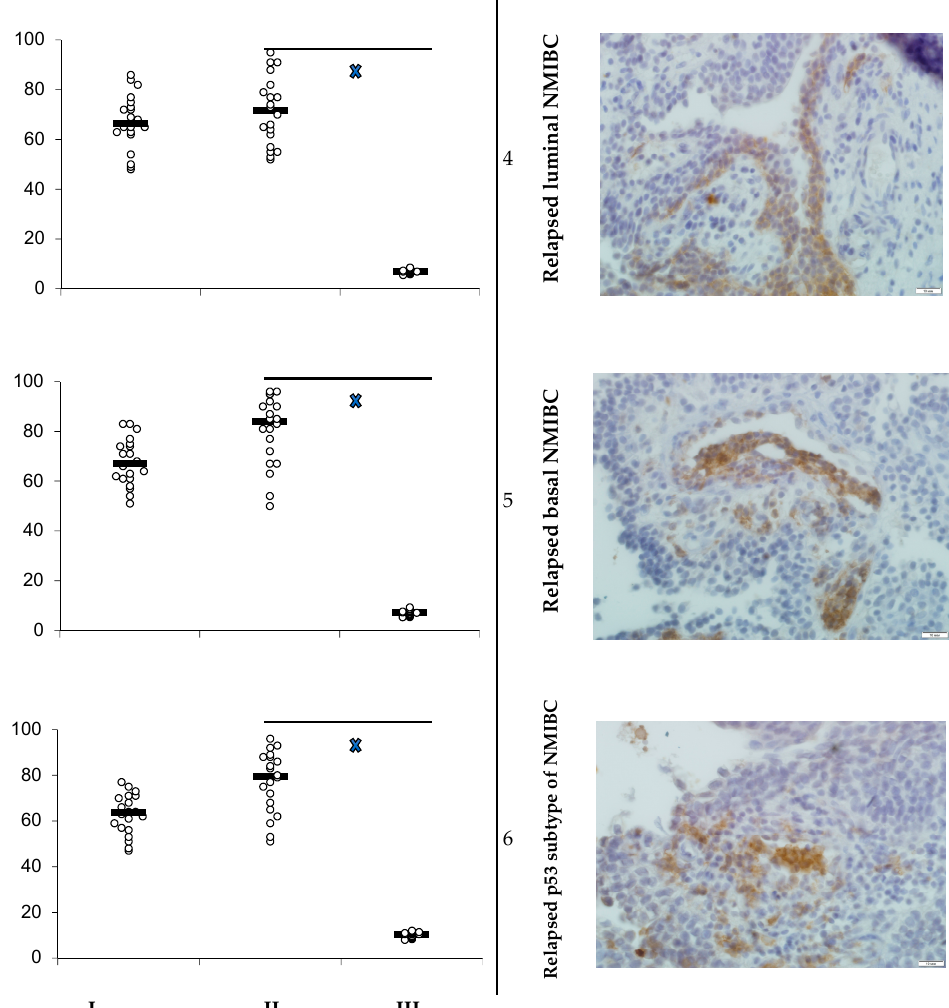
Figure 1. ( A ) PD-L1 expression in bladder cancer PDXs in dependence on PD-L1 treatment; PD-L1 expression as scatterplots of individual % of positively stained tumor cells with estimated median for maternal tumor used for engraftment ( I ), for PDX of control subgroup mice ( II ), and animals ( III ) utilized specific therapy ( n = 20 in maternal tumor group; n = 10 in each subgroup); x p < 0.05 when compared with control (Student’s t -test). ( B ) PD-L1-positive staining of primary luminal (1), basal (2), and p53 subtypes (3) of NMIBC, and relapsed luminal (4), basal (5), and p53 (6) subtypes of bladder cancer in maternal tumor’s specimens; IHC staining, x600.